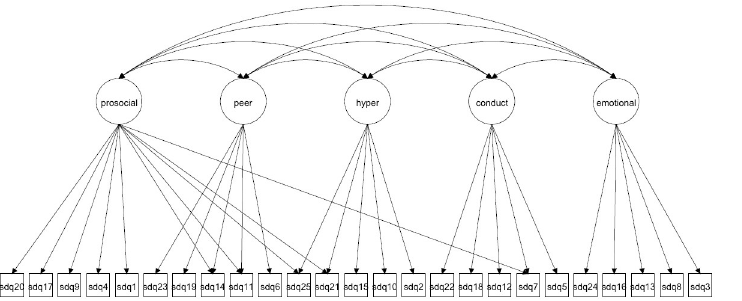
Fig 10. 5-factor model with cross-loadings (Model 6a).